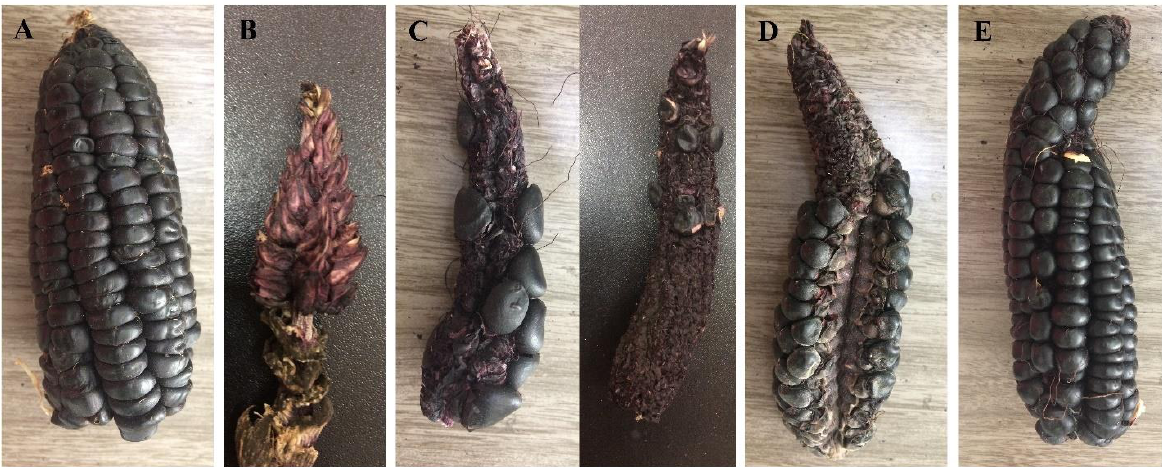
Figure 4. Sample of ears of corn from the Kculli race of treatment T1, with different signs of nutrient deficiency. Small ear with small grains, due to Mg and Mn deficiency ( A ); aborted ear without any grain formed ( B ); poorly filled ears with very few grains formed, due to N and K deficiency ( C ); small ear with P deficiency, with crooked tip and poorly developed kernels ( D ); and small ear, crooked at the tip due to grain abortion ( E ).